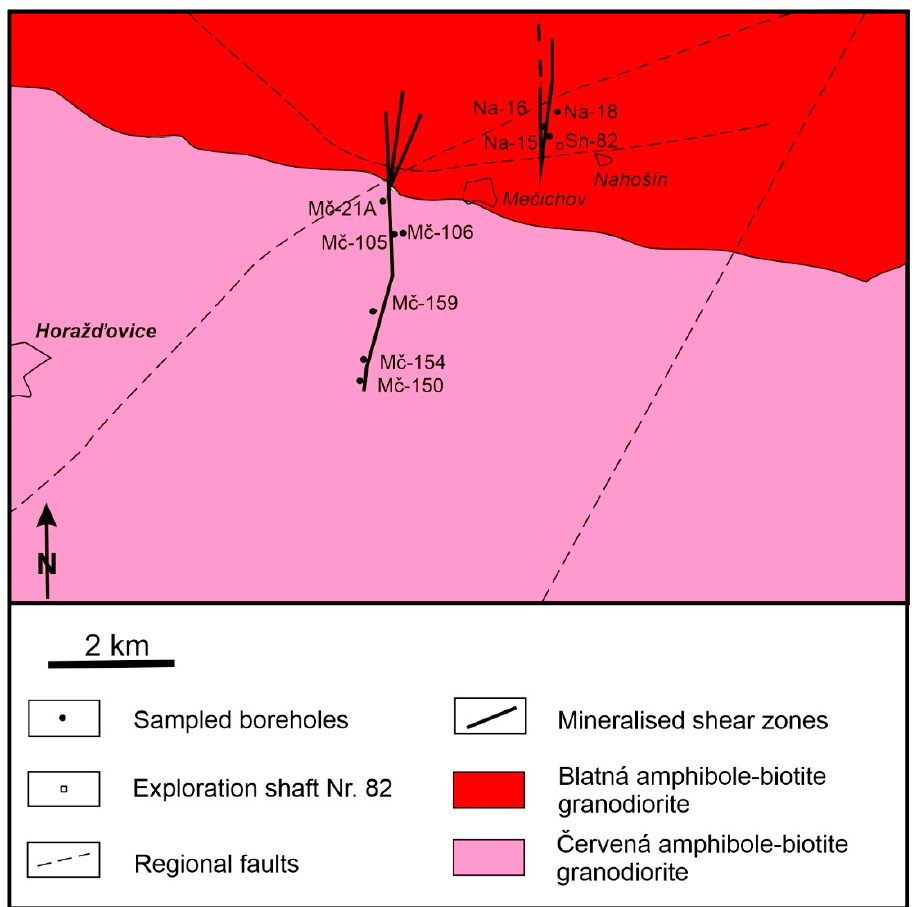
Figure 2. Schematic geological map of the Nahošín and Me č ichov uranium deposits, modified from [17].